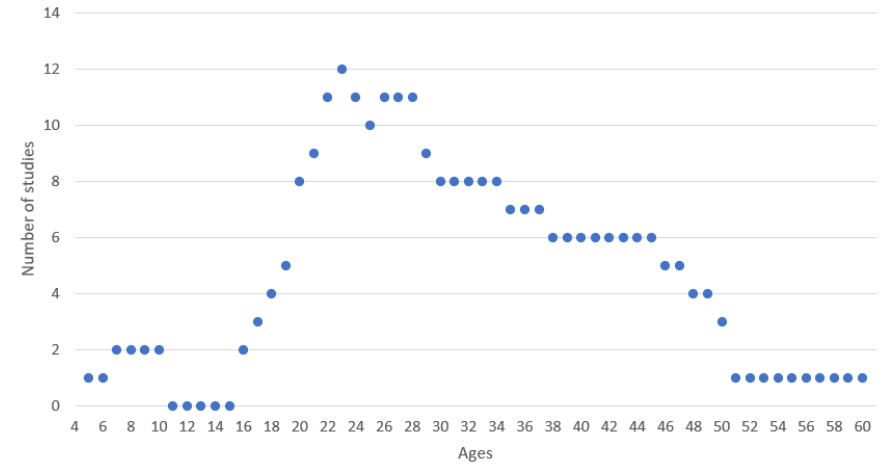
Figure 3. Relation of ages and number of studies.